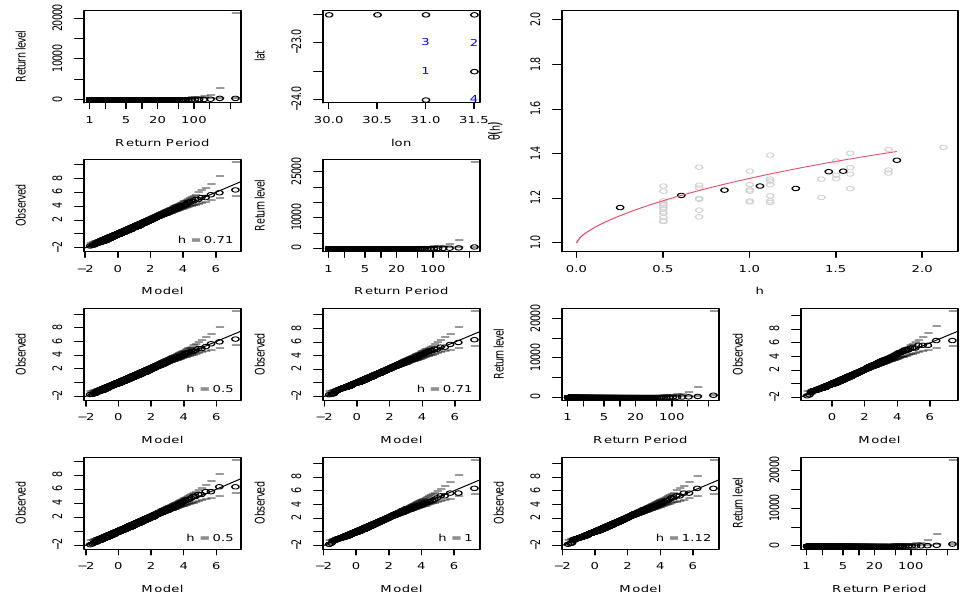
Figure A3. Diagnostic plots of the max-stable process fitted to the first cluster of average annual precipitation with a powered exponential covariance family.